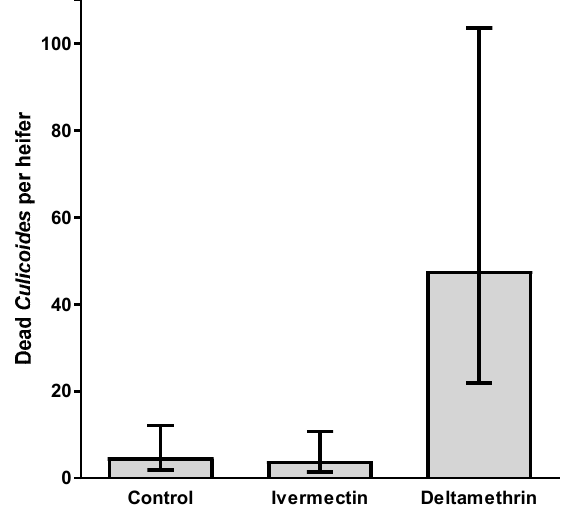
Figure 6. Mean number ( ± 95% confidence intervals) of dead Culicoides combed from heifers treated with ivermectin, deltamethrin or fenbendazole (control) ( n = 5). Data are back-transformed from GLMM predictions.